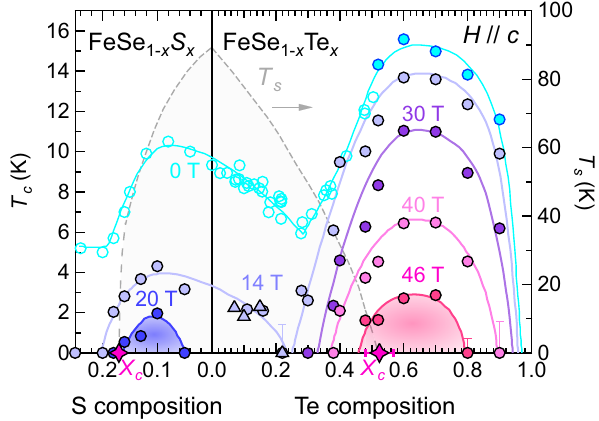
FIG. 3. Field-induced change of superconducting phases in FeSe-based superconductors. T values at finite fields are c determined from the temperature dependence of H measured c 2 by magnetoresistance (closed circles) and TDO technique (tri- angles). T values at zero field shown by open circles are taken c from the data previously measured in the single crystals grown by the CVT technique [24]. Zero-temperature intercepts of the structural transition T shown by the gray dashed line represent s the nematic quantum critical points x . All the solid lines are c guides to the